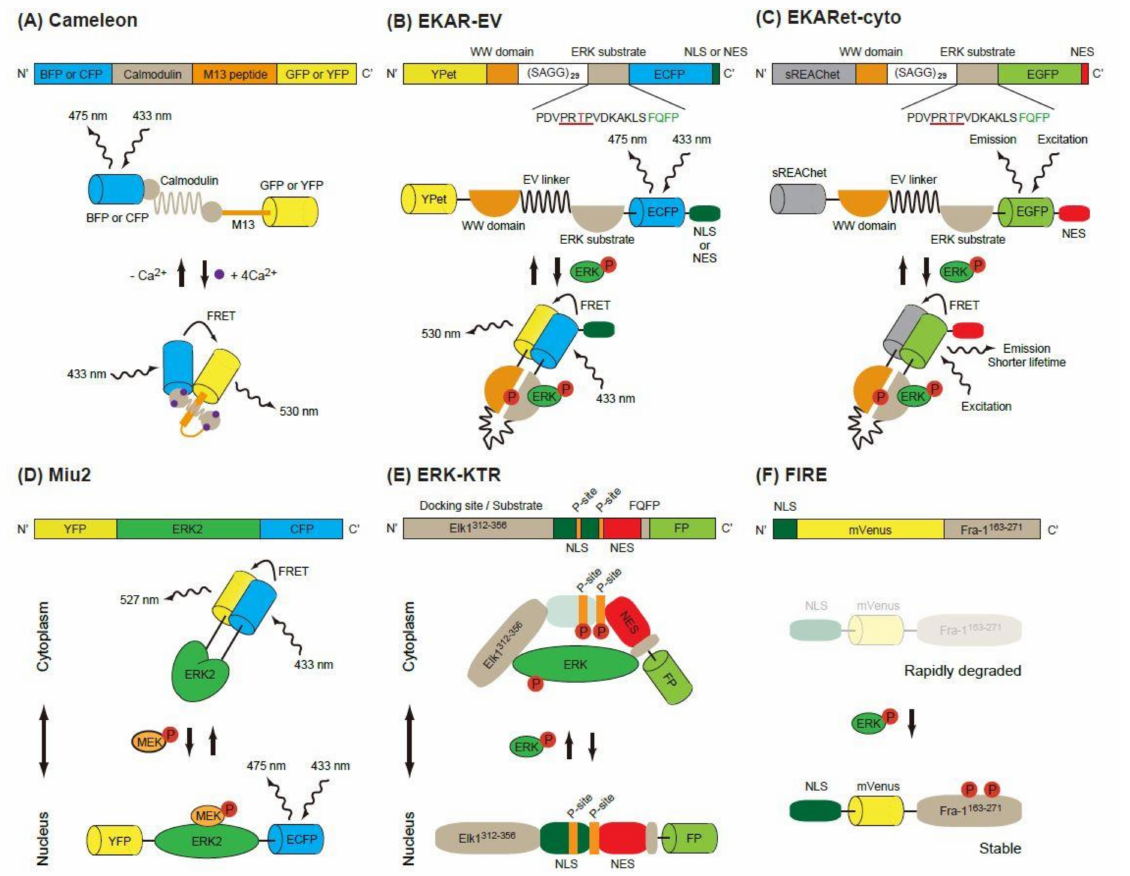
Figure 1. Schematic of single-molecule Förster (or fluorescence) resonance energy transfer (FRET)